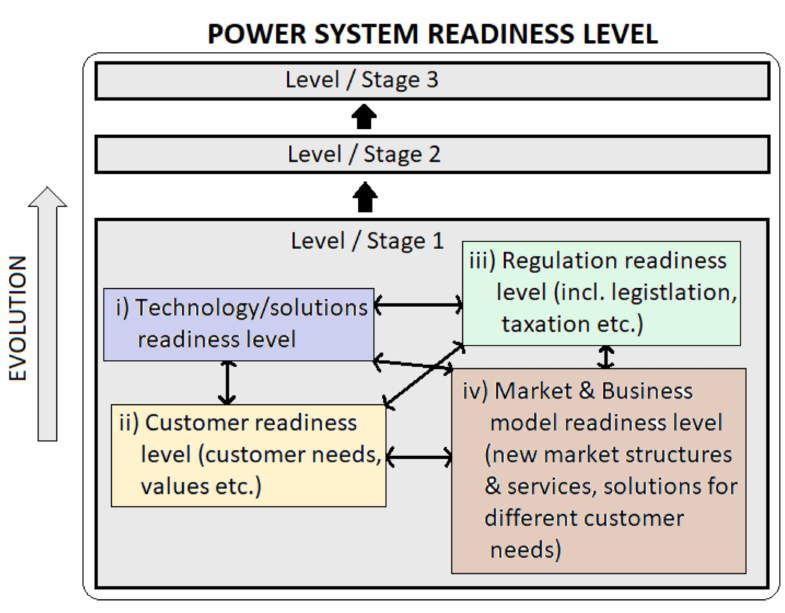
Figure 1. Power system readiness level, PSRL evolution that requires simultaneous develop- ment and readiness of (i) technology/solutions, (ii) customer, (iii) regulation, and (iv) market and business